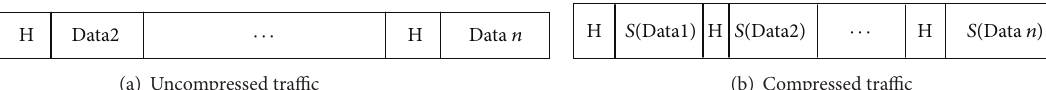
Figure 3: Stateless compression algorithm for packet payload.